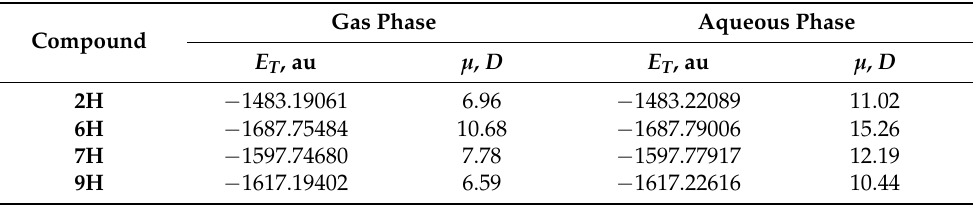
Table 2. The total electronic energy au and dipole moment D of the 2H , 6H , 7H , and 9H TUDHIPP derivatives at the B3LYP/6-311++G(d,p) level of calculation in the gas phase and aqueous phase. Gas Phase Aqueous Phase Compound E T , au µ , D E T , au µ , D